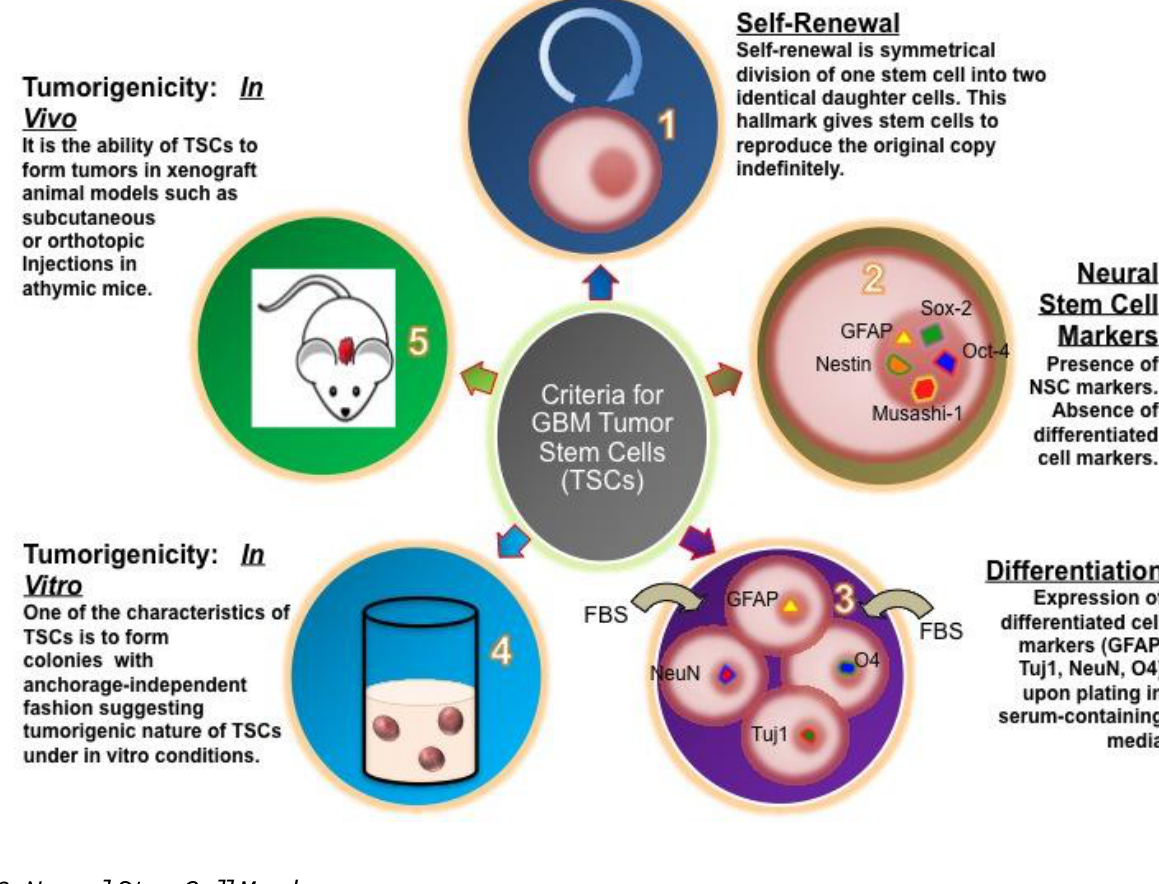
Figure 2. Schematic Presentation of GBM Stem Cell Criteria. The signature characteristics of tumor stem cells (TSCs) are ( 1 ). self-renewal; ( 2 ). expression of neural stem cell markers such as Nestin, Sox-2 and Musashi-1; ( 3 ). differentiation into oligodentrycitic, neuronal and astrocytic populations; ( 4 ). retaining tumorigenic nature under in vitro microenvironment and ( 5 ). formation of tumors in xenograft transplants in athymic